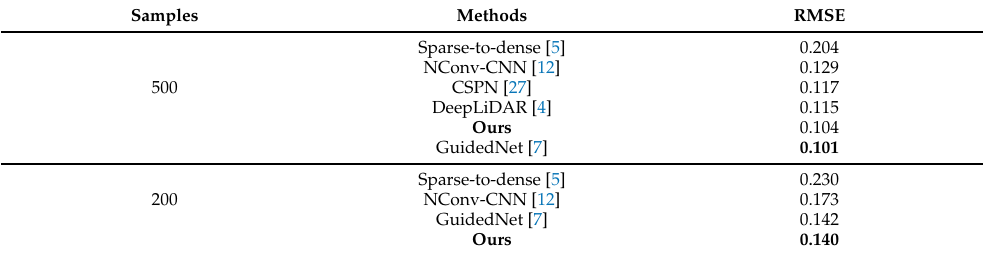
Table 2. Performance comparison using the NYUv2 dataset. The settings of both 200 samples and 500 samples were evaluated.